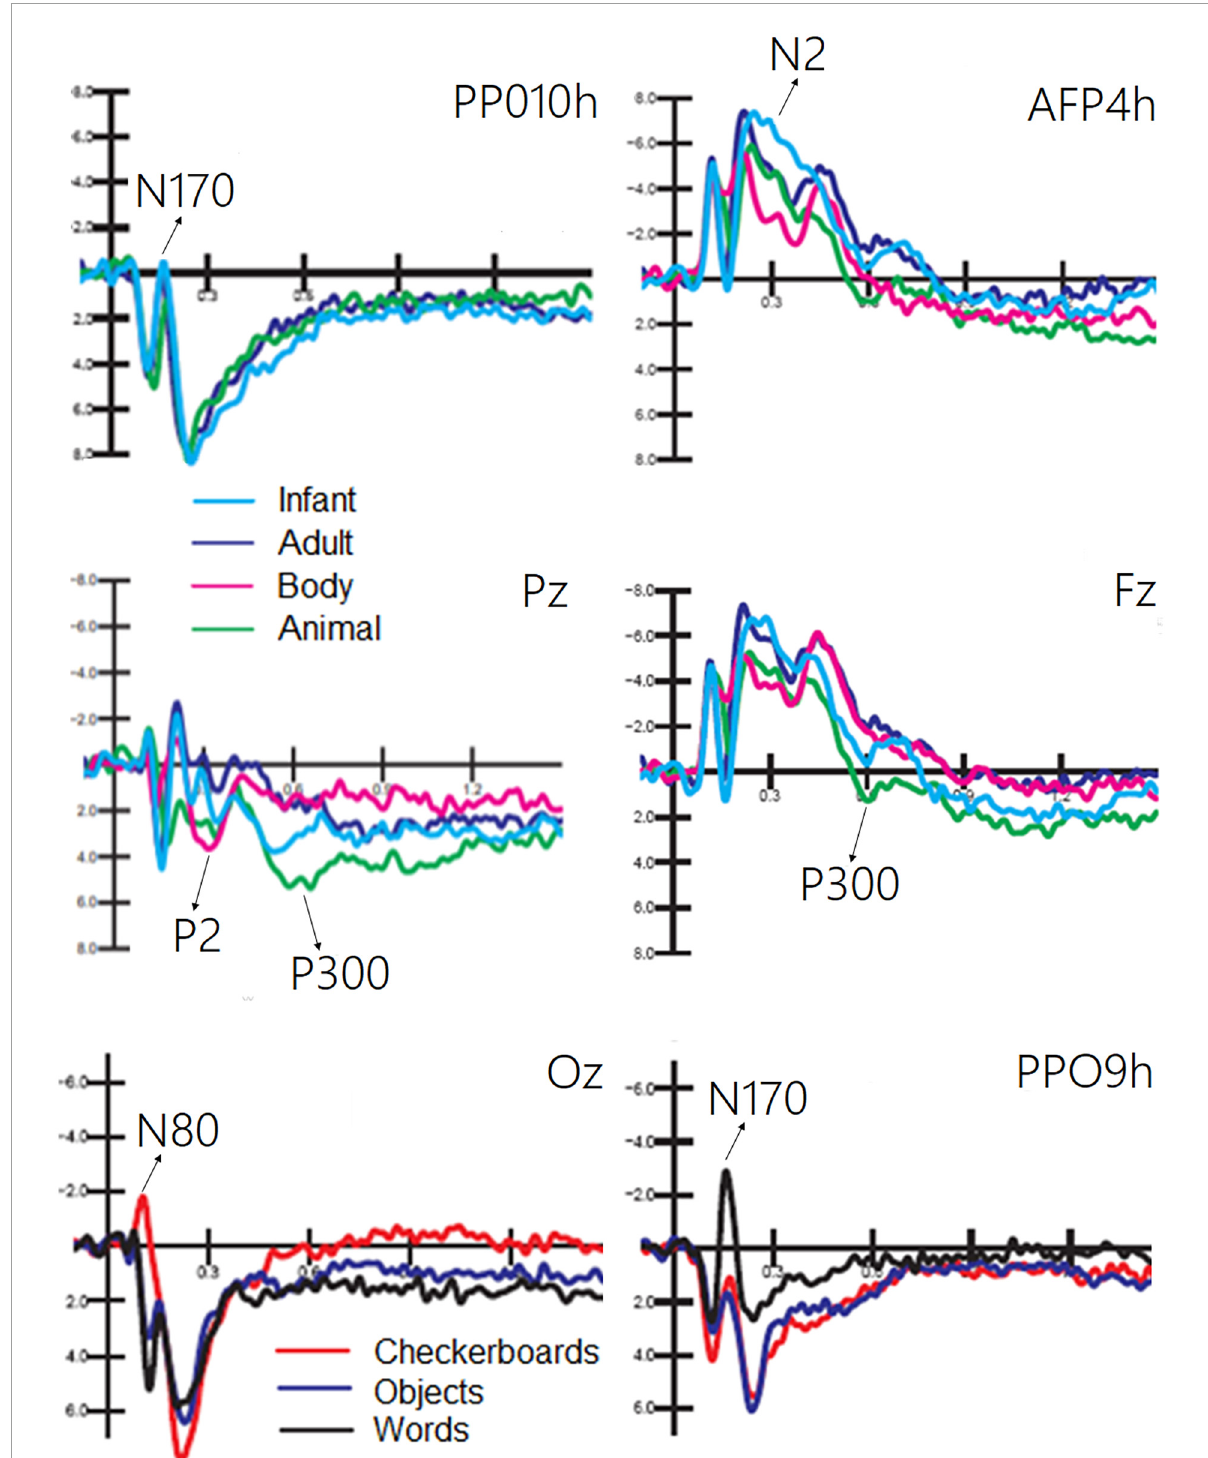
FIGURE4 Grand average ERPs recorded at different electrode sites as a function of sensory modality and stimulus category. The ERP components act as reliable markers of semantically distinct perceptual processing, as proved by statistical